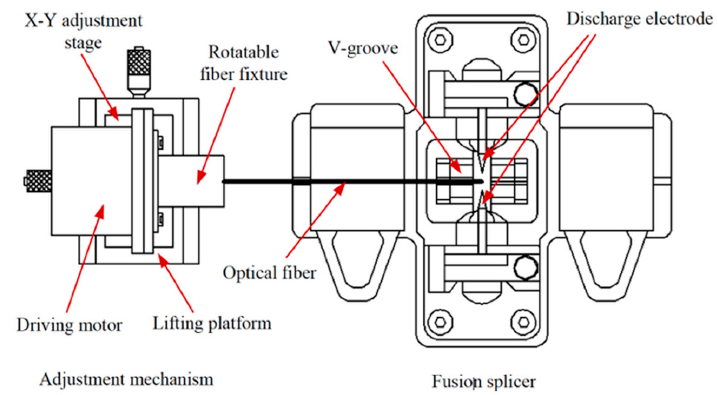
Figure 2. Schematic drawing of the apparatus to produce an integrated optical fiber microsphere in a fusion splicer. Reproduced from [13] under Creative Commons license.